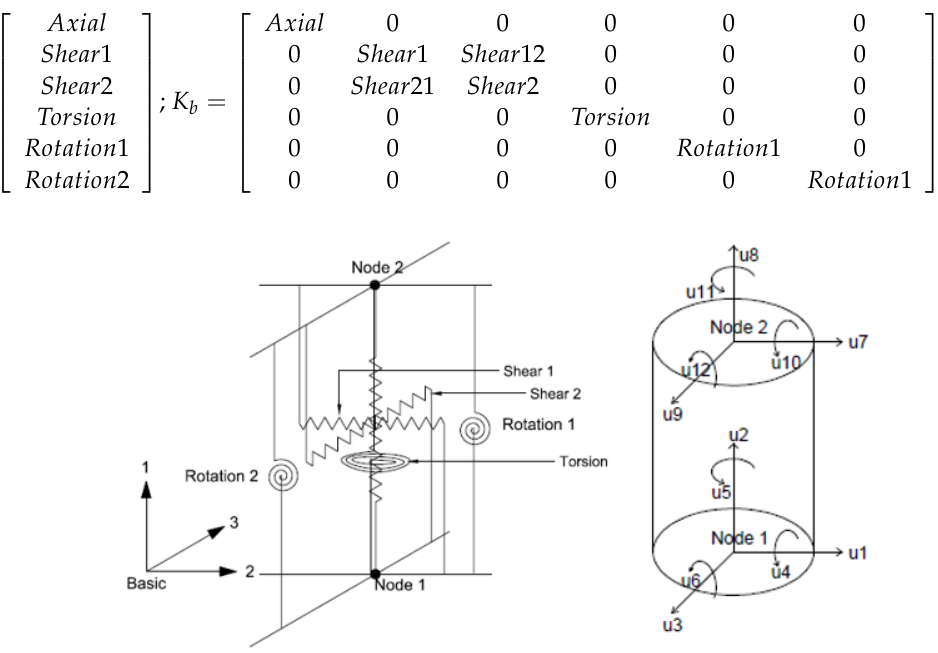
Figure 30. Schematic view of translational and rotational springs with local axis [90].